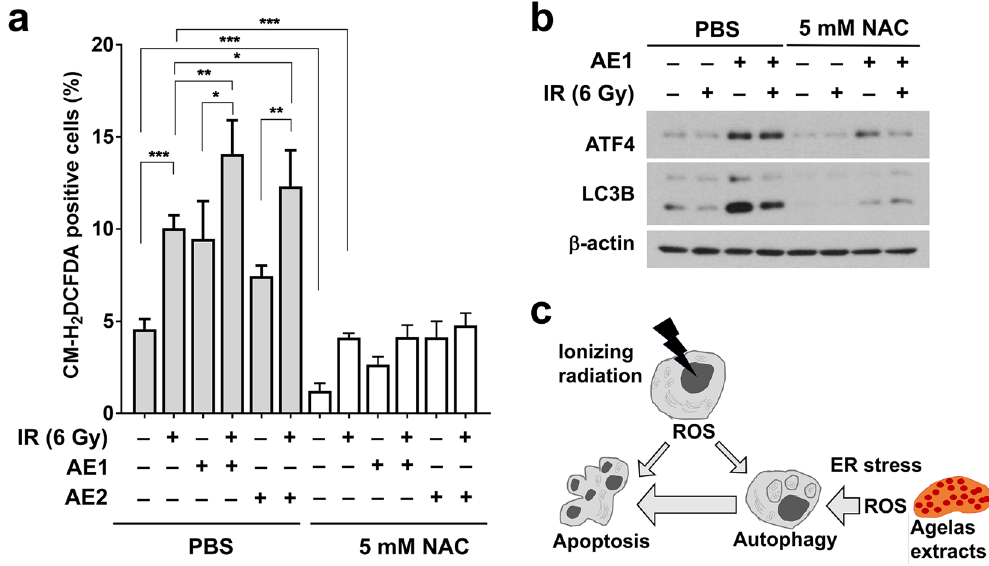
Figure 5. The Agelas extracts augment IR-induced ROS production. ( a ) Hep3B cells were pre-incubated with 10 µ g/mL of AE1 or AE2 and CM-H 2 DCFDA for 3 h, followed by exposure to 6 Gy of IR. After 48 h of incubation, intracellular ROS levels were determined by DCF fluorescence using Flow cytometry. * p < 0.05, ** p < 0.01, *** p < 0.001. ( b ) N-acetylcysteine (NAC) abolished the induction of ER-stress and autophagy by the Agelas extracts. Pre-treatment with 5 mM NAC decreased AE1-induced expression of ATF4 and LC3B-II. PBS, phosphate buffered saline. Uncropped images are shown in Supplementary Fig. S3. (c) Schematic diagram of how the Agelas extracts increase radiosensitization in Hep3B